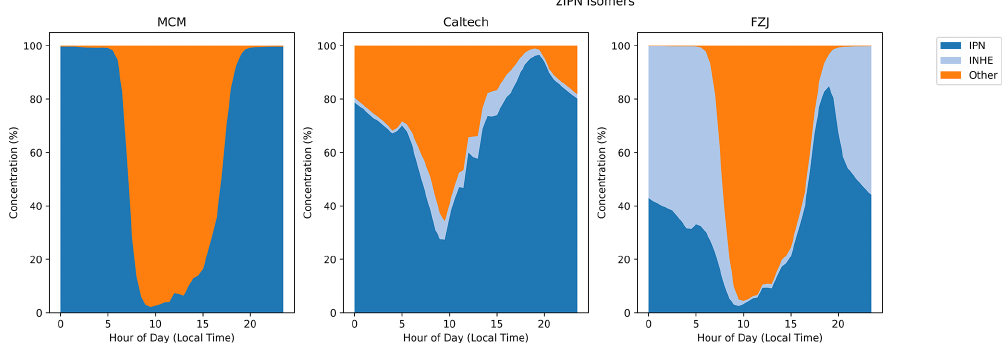
Figure 11. Isomer composition of the modelled (cid:54) IPN as a percentage of total (cid:54) IPN. “Other” is comprised of ISOP1N253OH4OH, C530NO3, PPEN, C524NO3, C51NO3, and C5PAN4.